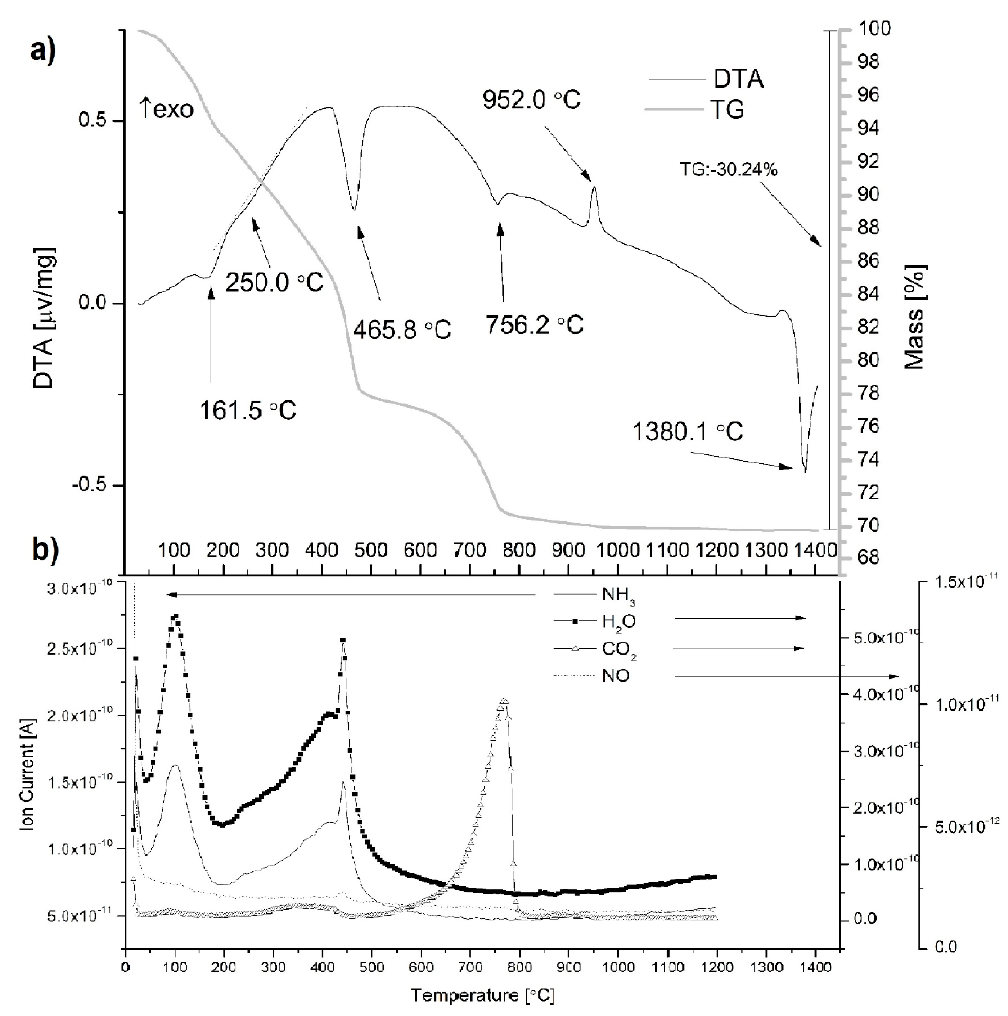
Figure 1. TG/DTA curves ( a ), and selected curves of mass-spectroscopic ion currents ( b ) for gases evolved during heating from the as-synthesized powder.